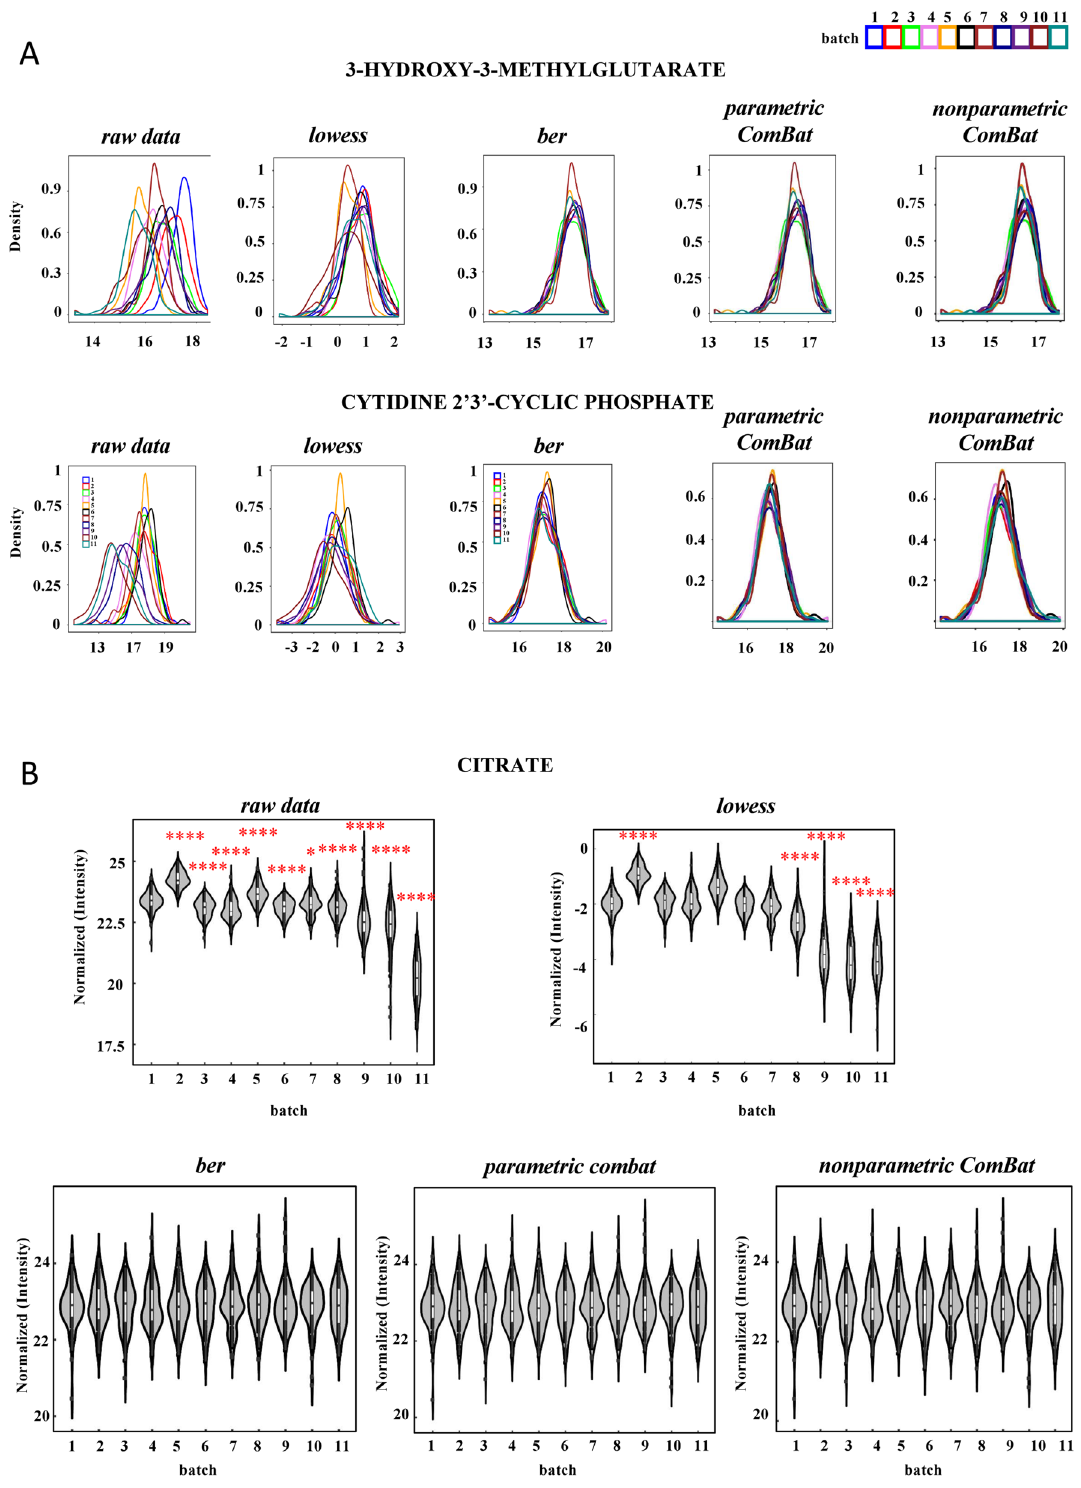
Figure 2. Monitoring of batch effect at feature levels in the LC–MS targeted metabolomics analysis of the SKIPOGH human cross- sectional study with “dbnorm” . 1079 plasma Samples were analyzed in 11 analytical batches over a period of 12 months. 239 metabolites were detected. ( A ) Probability density function ( PDF ) plots of 3-Hydroxy-3-methylglutarate and Cytidine 2 ′ ,3 ′ -cyclic phosphate across different experimental runs showed the shift in the distribution of signals in raw data and its adjustment after data lowess -, ber -, parametric ComBat-, and nonparametric ComBat- correction. 3-Hydroxy-3-methylglutarate and Cytidine 2 ′ ,3 ′ -cyclic phosphate peaks are detected in positive and negative mode of acquisitions, respectively. ( B ) Violin plots of superposed scatter plots across batches for citrate intensities showed the shift of average distribution across-batches in raw data, which was still present in some batches in lowess -adjusted data. This shift is corrected by ber , parametric ComBat, and nonparametric ComBat . Dots correspond to the level of citrate in each sample and the average citrate level in each batch is defined by boxplot. Two-tailed Student’s t -test was used to calculate the significant changes of citrate mean level in different batches compared to the batch 1. *, **, *** and **** indicate p-value < 0.05, < 0.01, < 0.001, < 0.0001,